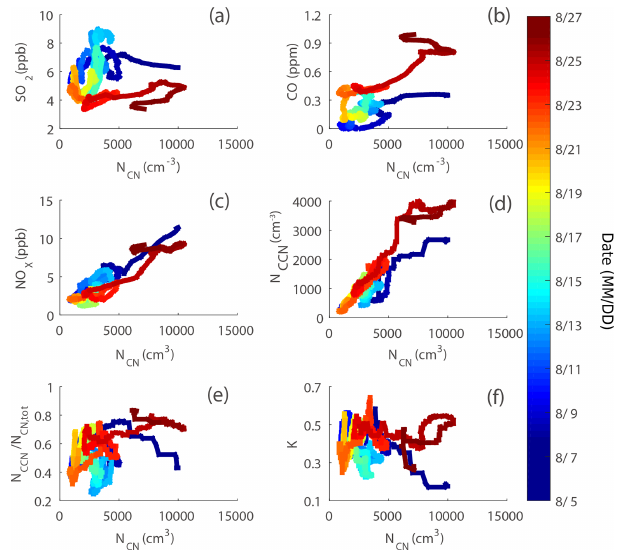
Figure 5. Correlations of SO 2 (a) , CO (b) , NO x (c) , N CCN (d) , AR at 0.34%ss (e) , and κ at 0.34%ss (f) with N CN . The data were plotted according to color-coded dates.